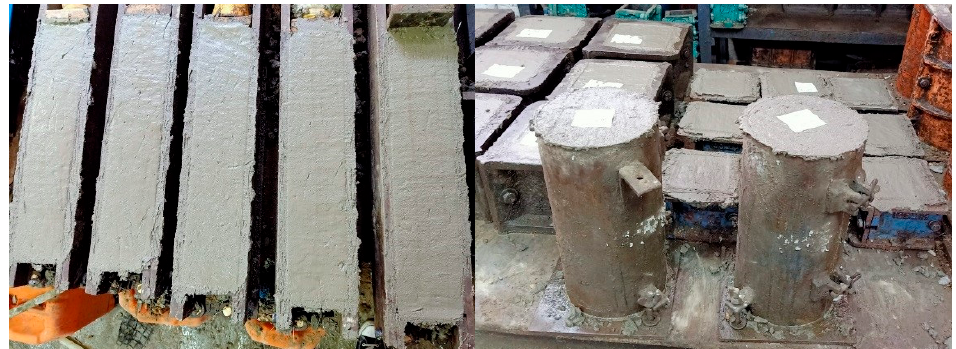
Figure 3. Concrete specimens.